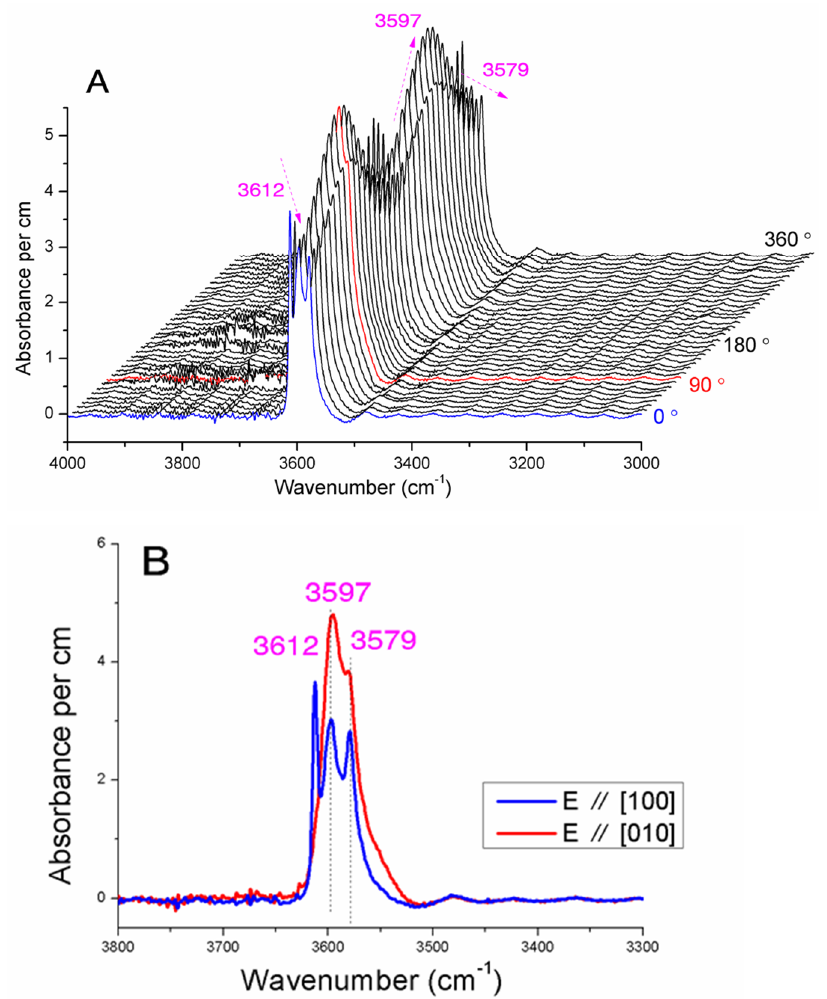
Figure 5. ( A ) IR absorption spectra of polarized IR propagating vector ⊥ (001) plane of forsterite, (E vector of light vibrating parallel to the b axis was labeled as 0°) show the angle between IR light vibration vector (E) and the original directions (360° in total with a 10° interval). ( B ) The IR absorption spectra of the [100] and [010] direction.